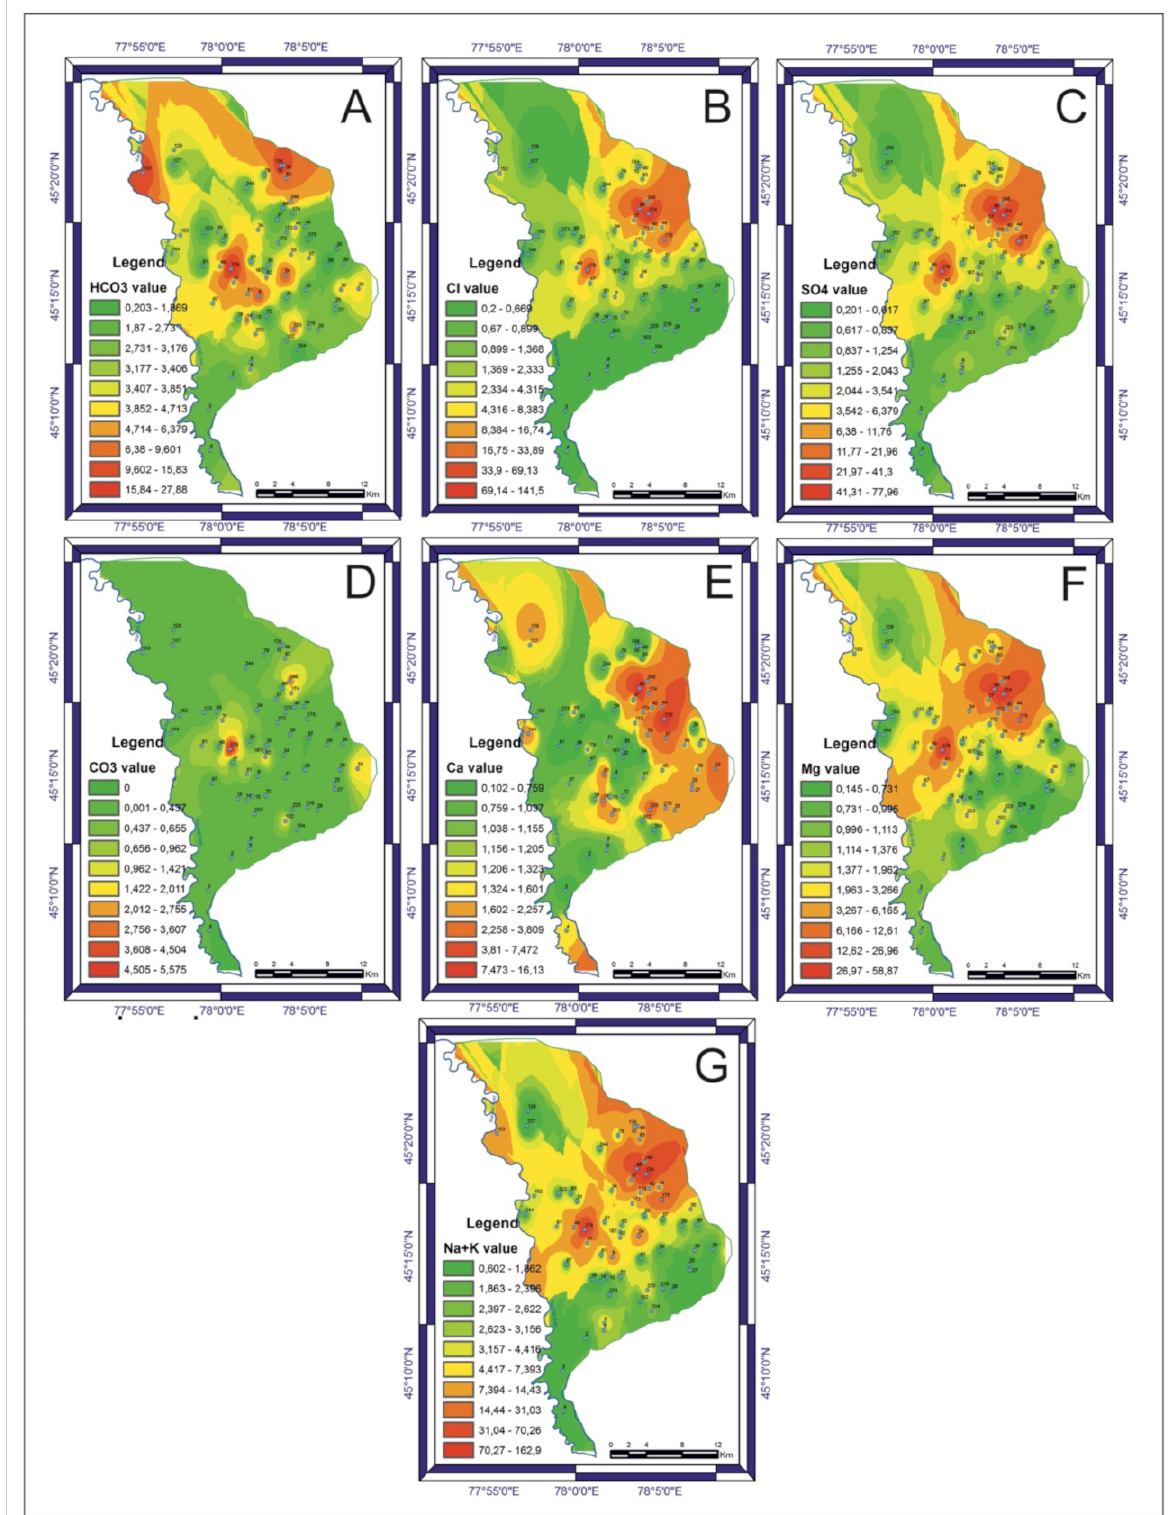
Figure 7. Maps of the spatial distribution of ions for the post-vegetation period: ( A )—HCO 3 , ( B )—Cl, ( C )—SO 4 , ( D )—CO 3 , ( E )—Ca, ( F )—Mg, ( G )—Na+K. The enrichment of groundwater with sodium cations is explained by the processes of ion exchange with soil solutions of rocks of the aeration zone. According to researchers